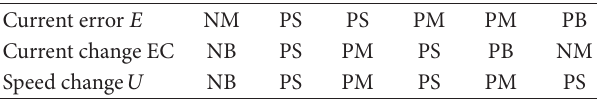
Table 3: The fuzzy quantization relations between the input and